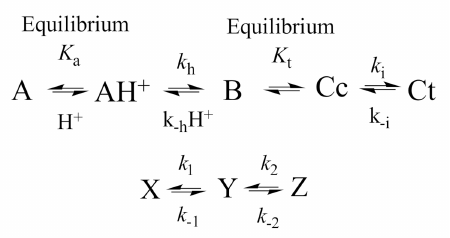
Scheme 5. Kinetic scheme of a flavylium multistate lacking the pseudo-equilibrium.